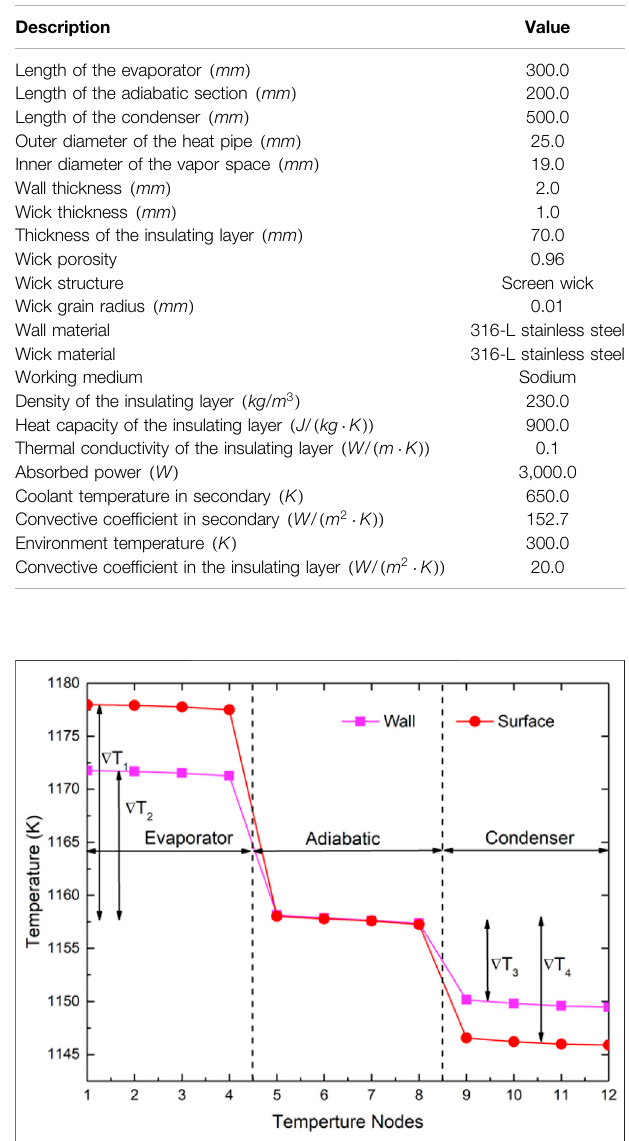
TABLE 2 | Parameter description of a sodium heat pipe.